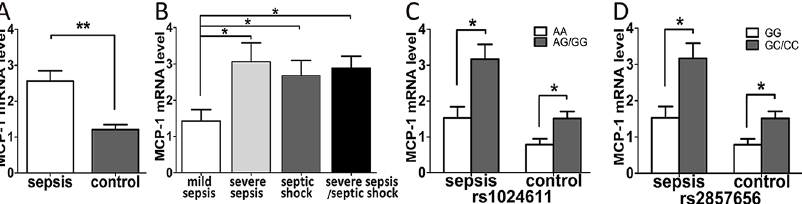
Fig 2. Real-time PCR analysis of the monocyte chemo-attractant protein 1 (MCP-1) mRNA expression levels in sepsis cases (n = 80) and healthy controls (n = 80). Expression levels of MCP-1 in sepsis patients and healthycontrols (A). Expression levels of MCP-1 in mild sepsis, severe sepsis and septic shock subgroups (B). The distributionof MCP-1 mRNA expressionlevels in groups of sepsis patients with different rs1024611 genotypes(C) and different rs2857656 genotypes (D). The horizontalline stands for the median expressionlevel with each group. * P < 0.05; ** P < 0.01; *** P <